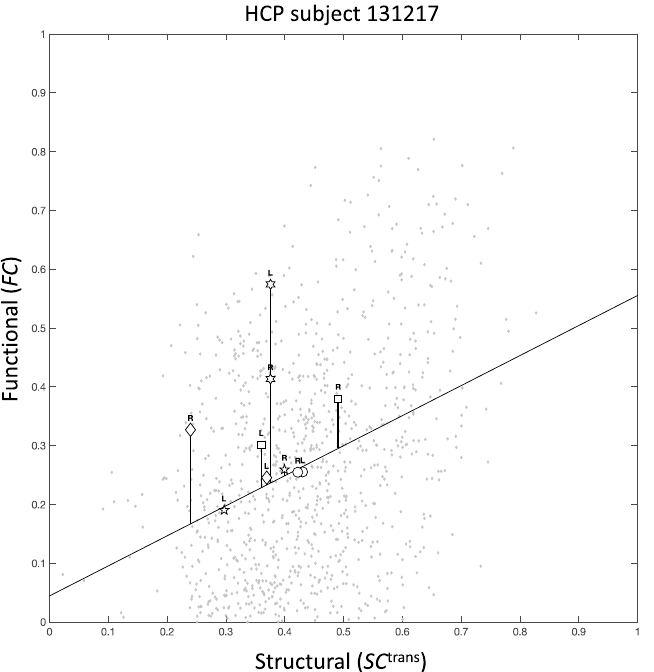
Figure 5. Scatterplot of empirical FC against SC trans for a representative subject. Representative subject is taken from the HCP dataset. The data points for several bilateral pairs are indicated: circles—no FC-SC mismatch in neither of the connections, same SC trans and same FC (isthmus of cingulate gyrus-thalamus proper), pentagrams—no FC-SC mismatch in neither of the connections, different SC trans and proportional relative difference in FC (inferior temporal-banks of superior temporal sulcus), squares—comparable FC-SC mismatch in both connections, different SC trans and a proportional relative difference in FC (pars operculis-inferior parietal), hexagrams—different FC-SC mismatch in each connection, same SC trans but different FC (rostral middle frontal-superior parietal), diamonds—different FC-SC mismatch in each connection, different SC trans and also a difference in FC that is not proportional to the difference in SC trans (caudal middle frontal-lateral occipital). Note that a pattern at the level of a single subject might not reflect the common pattern across the group. Conventions are as in Fig.